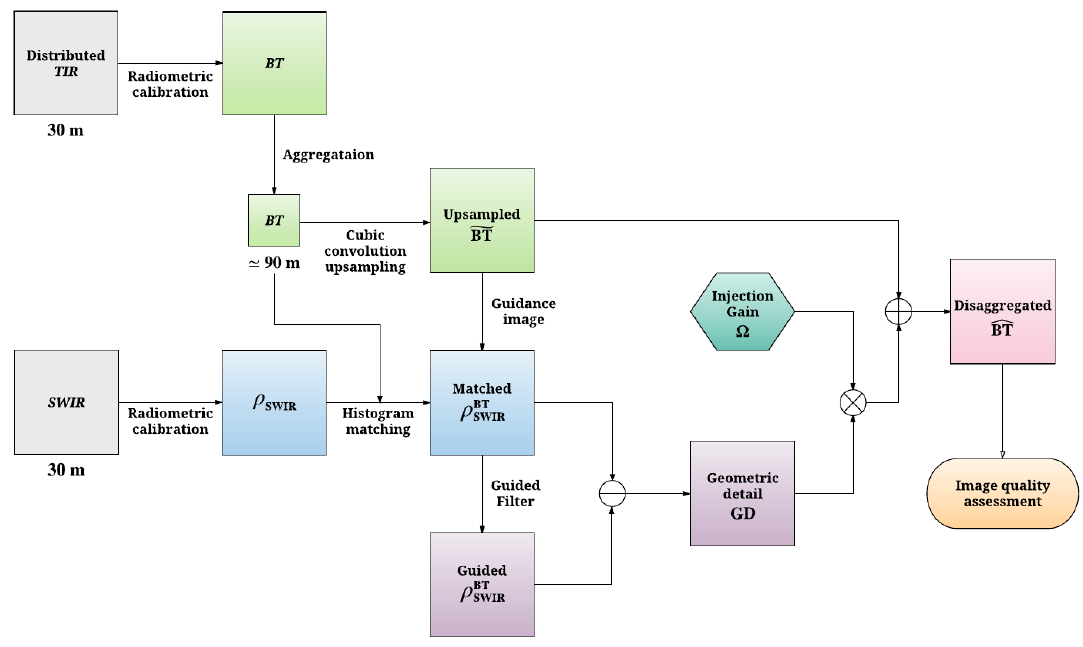
Figure 2. Flowchart for the proposed disaggregation method of TIR data.